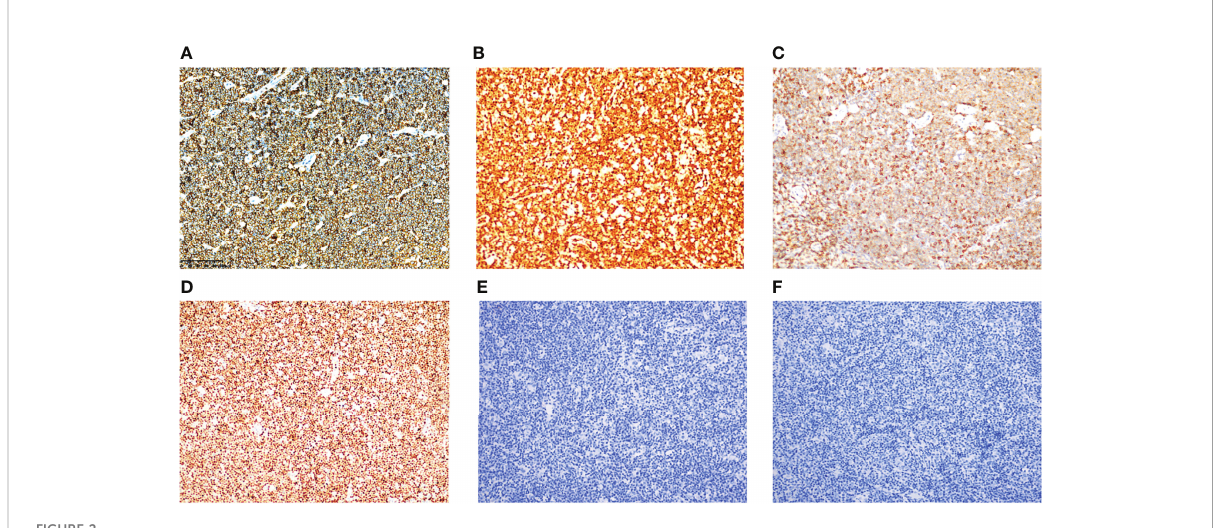
FIGURE 2 Immunohistochemical expression of MCL with EBER positivity. Tumor cells were positive for CD79a (A) (case 2), CCND1 (B) (case 2), CD5 (C) (case 4), and SOX11 (D) (case 3). Tumor cells were negative for LMP1 (E) (case 1) and EBNA2 (F) (case 1). All images were captured at ×200 magni fi